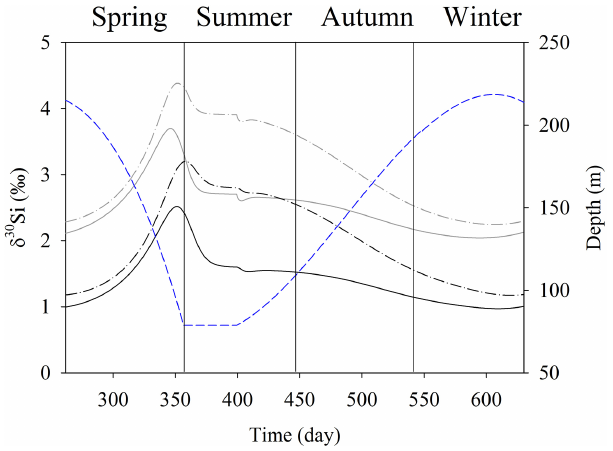
Fig. 12. Evolution of δ 30 Si for DSi (grey lines) and BSi (black lines) versus time for the initial model run (solid lines) and for the model run where δ 30 Si WW is allowed to vary with the ML depth (blue dashed